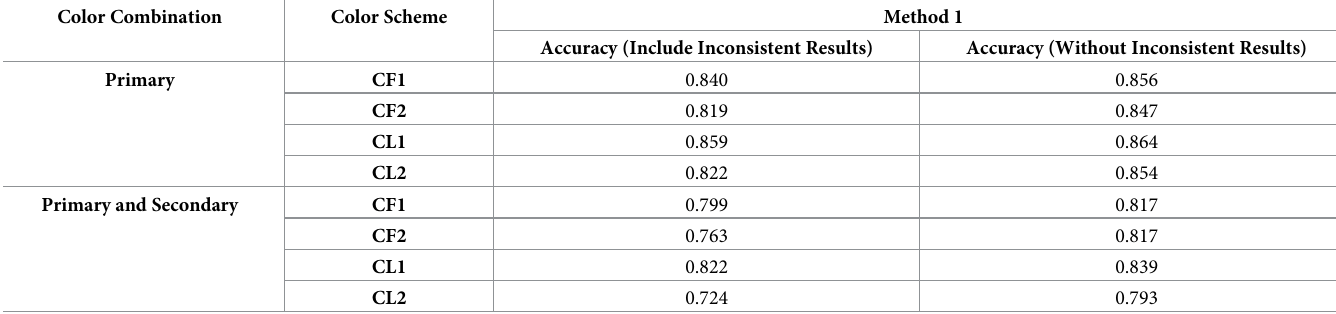
Table 6. Accuracy of method 1 by including and excluding inconsistent